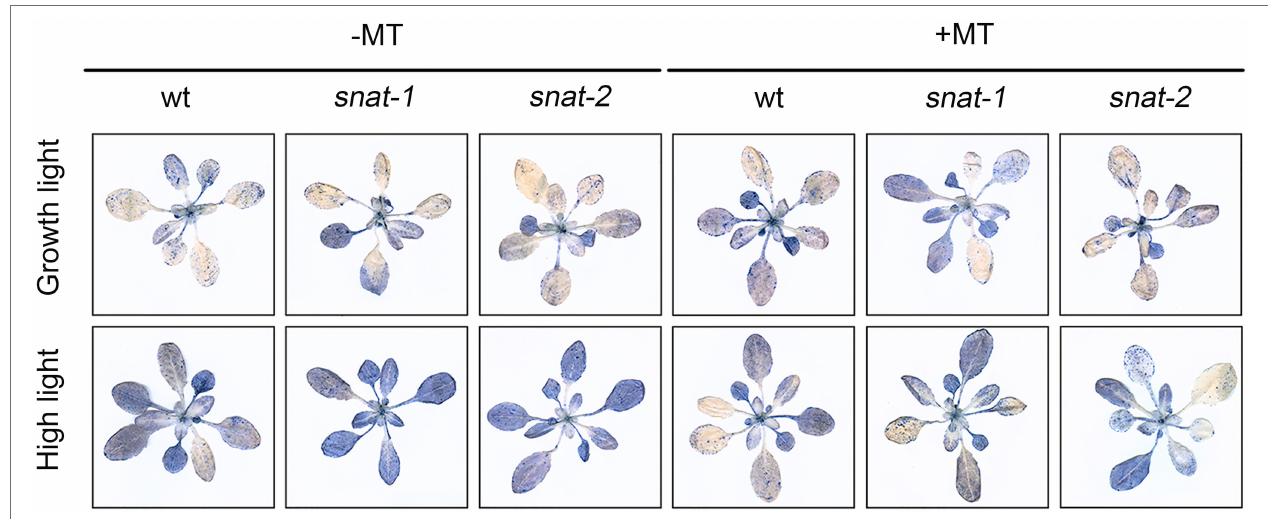
FIGURE 6 | Effects of exogenous melatonin on cell death. Trypan-blue staining of the Col-0 and mutants ( snat-1 , snat-2 ) under the growth light and high